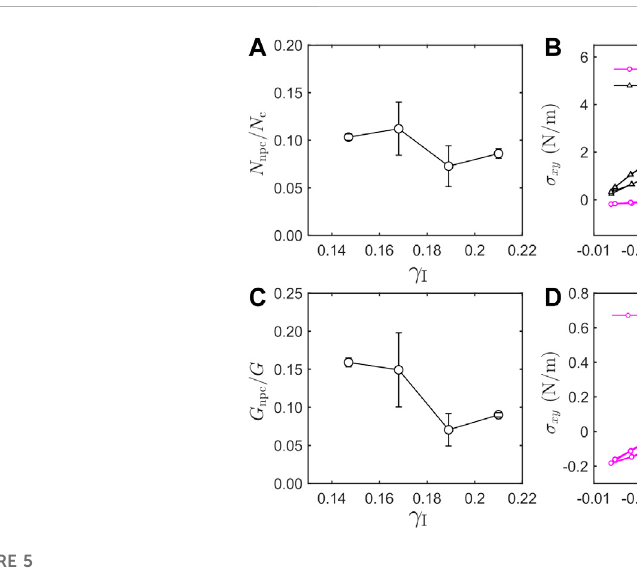
γ I . (B) Theshearstress